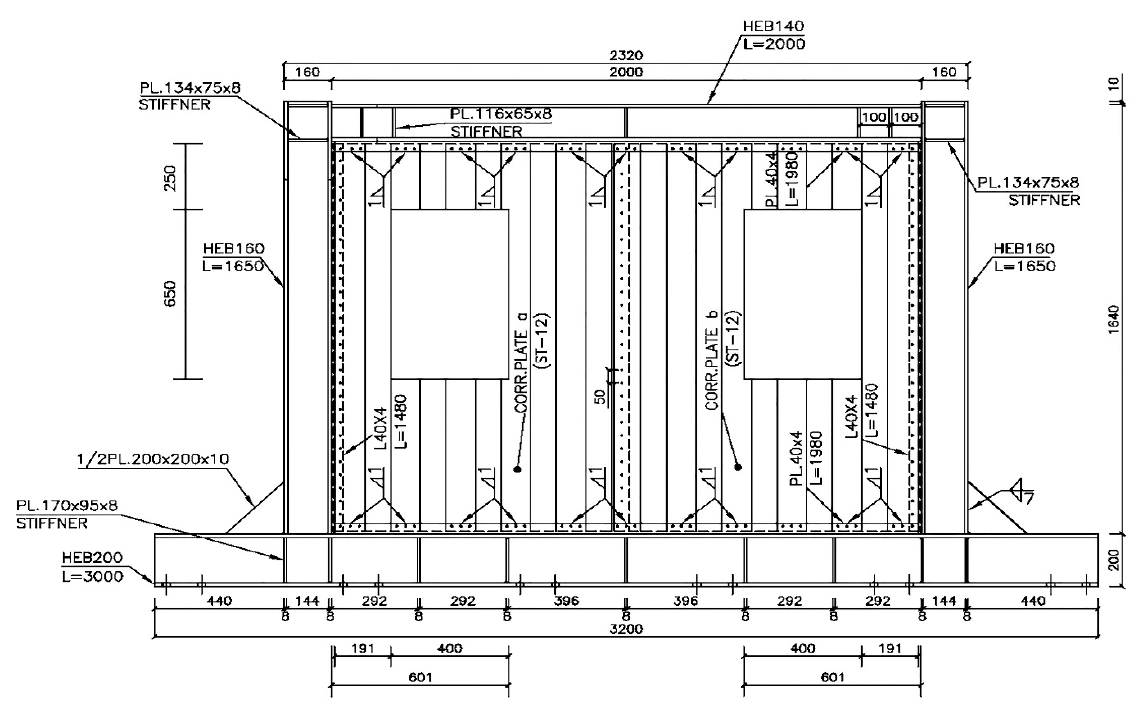
Figure 2. Details of specimen 2 (mm).